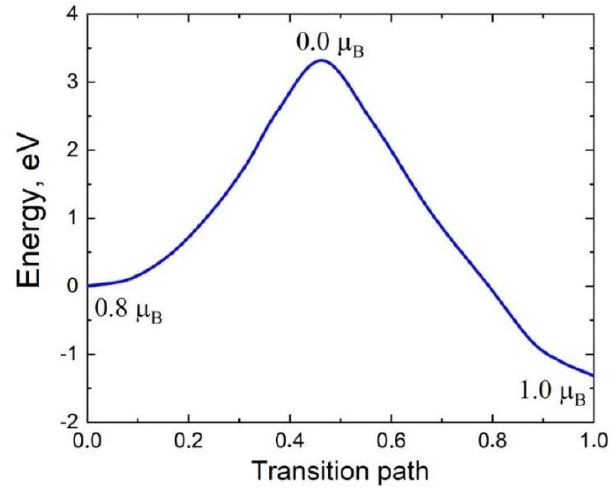
Figure 9. Energy profile of the transition of a silicon vacancy in the model system (Figure 8) from the initial metastable state V Si to stable C 4 V. The transition proceeds through a nonmagnetic transition state.